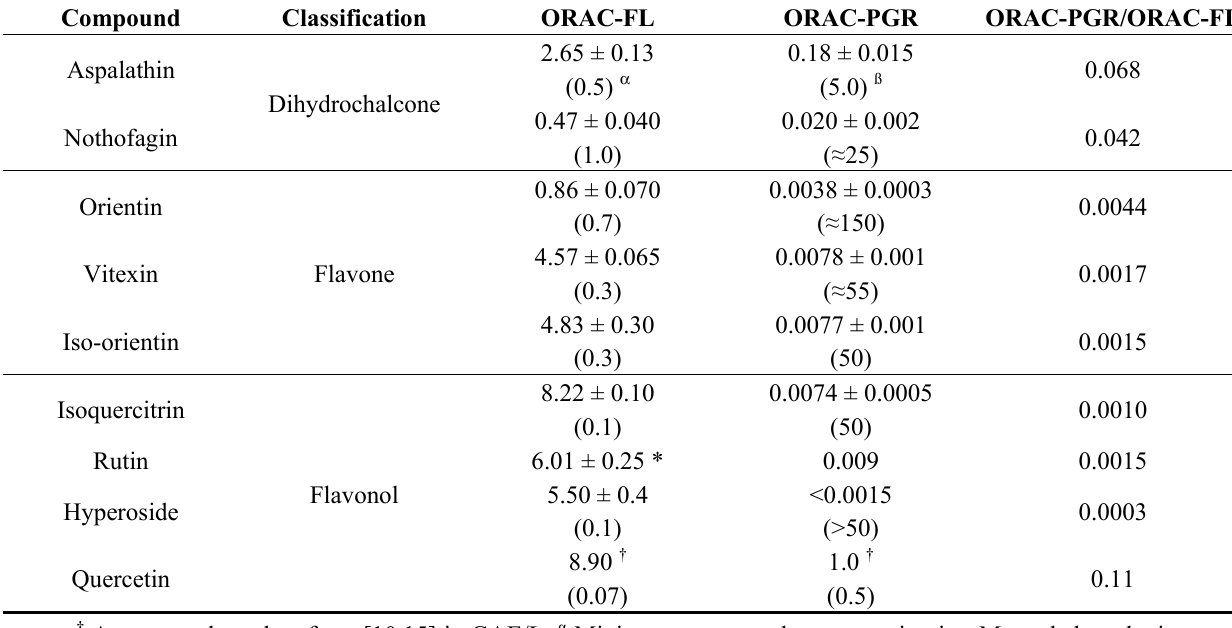
Table 1. ORAC indices for pure glycosylated polyphenols and quercetin expressed in gallic acid equivalents